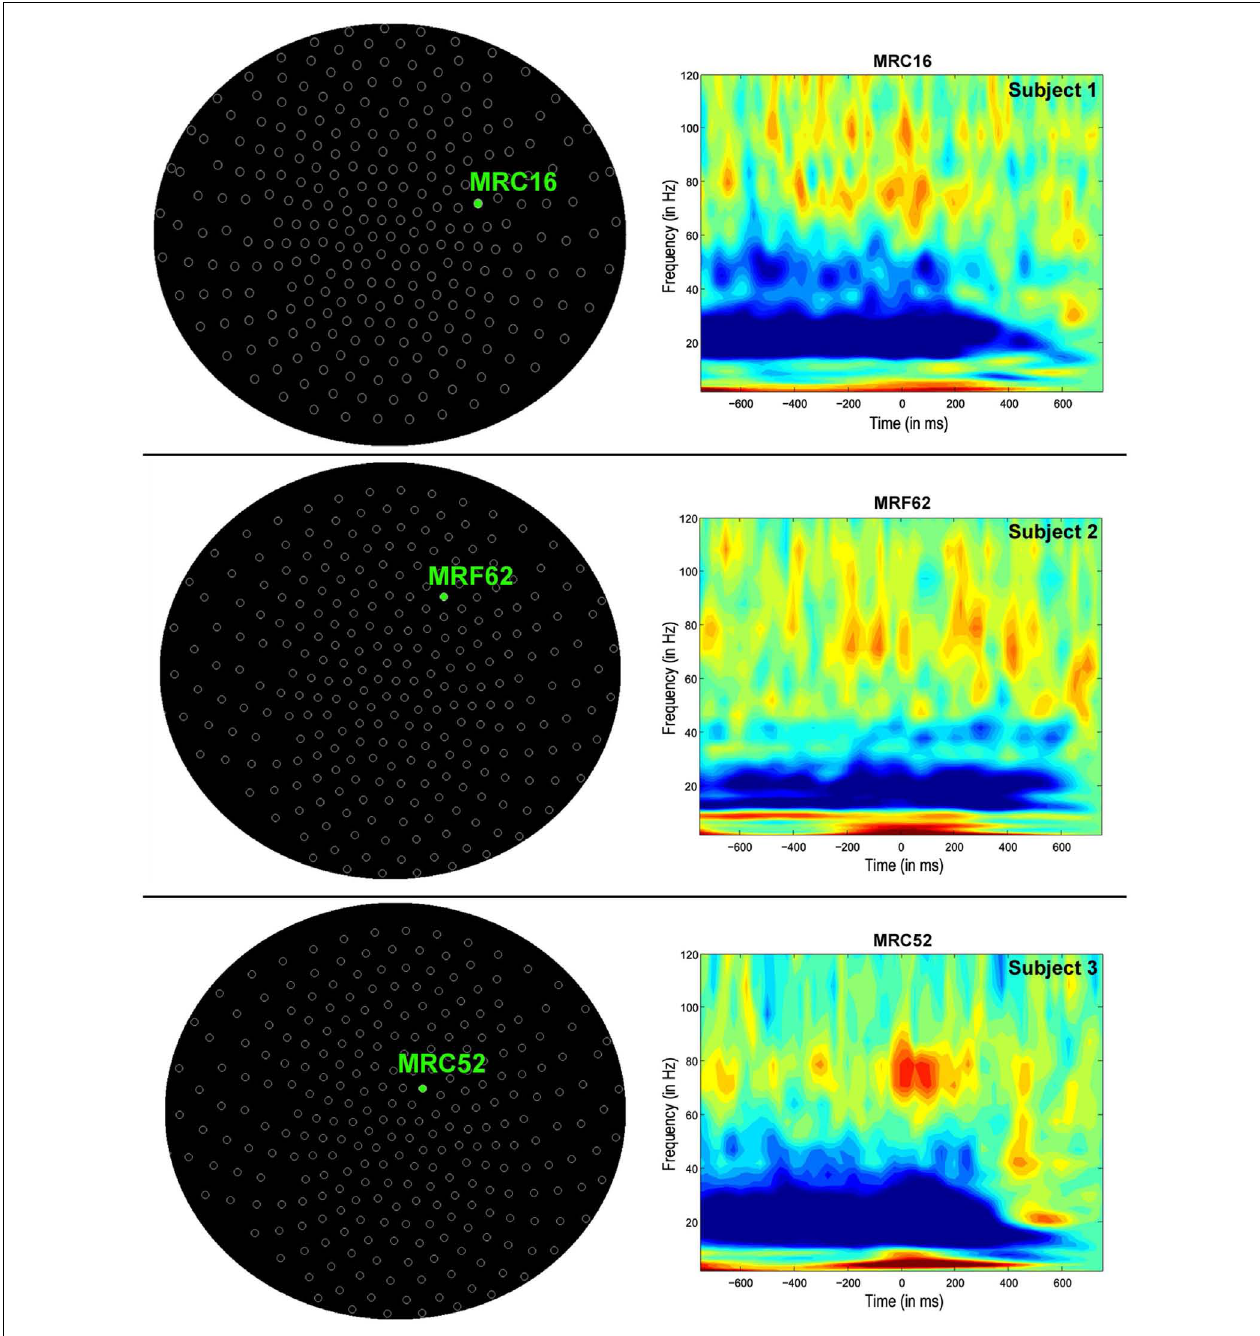
transform) of a single MEG sensor shows strong beta power ( ∼ 20Hz) suppression and high gamma synchronization ( ∼ 80Hz) both preceding and around movement onset